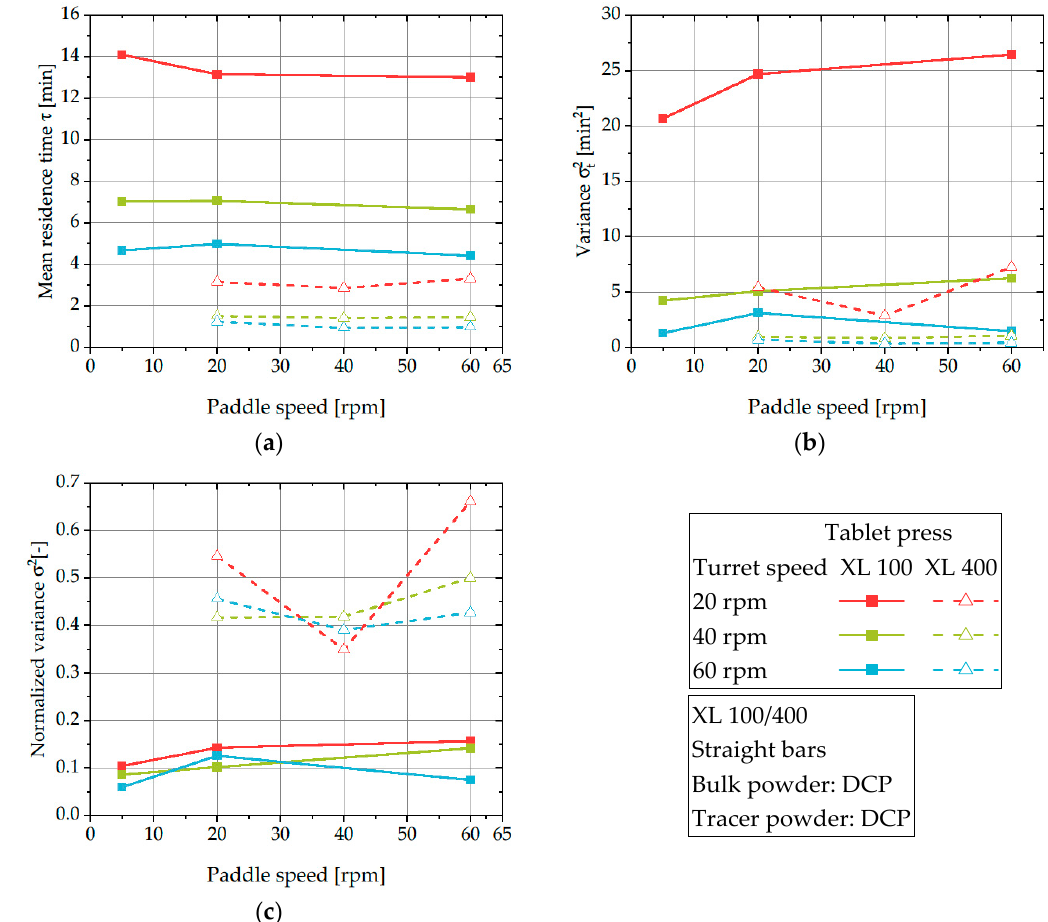
Figure 10. Mean residence time ( a ), variance ( b ), and normalized variance ( c ) of DCP on different scales of rotary tablets for varying process parameters.